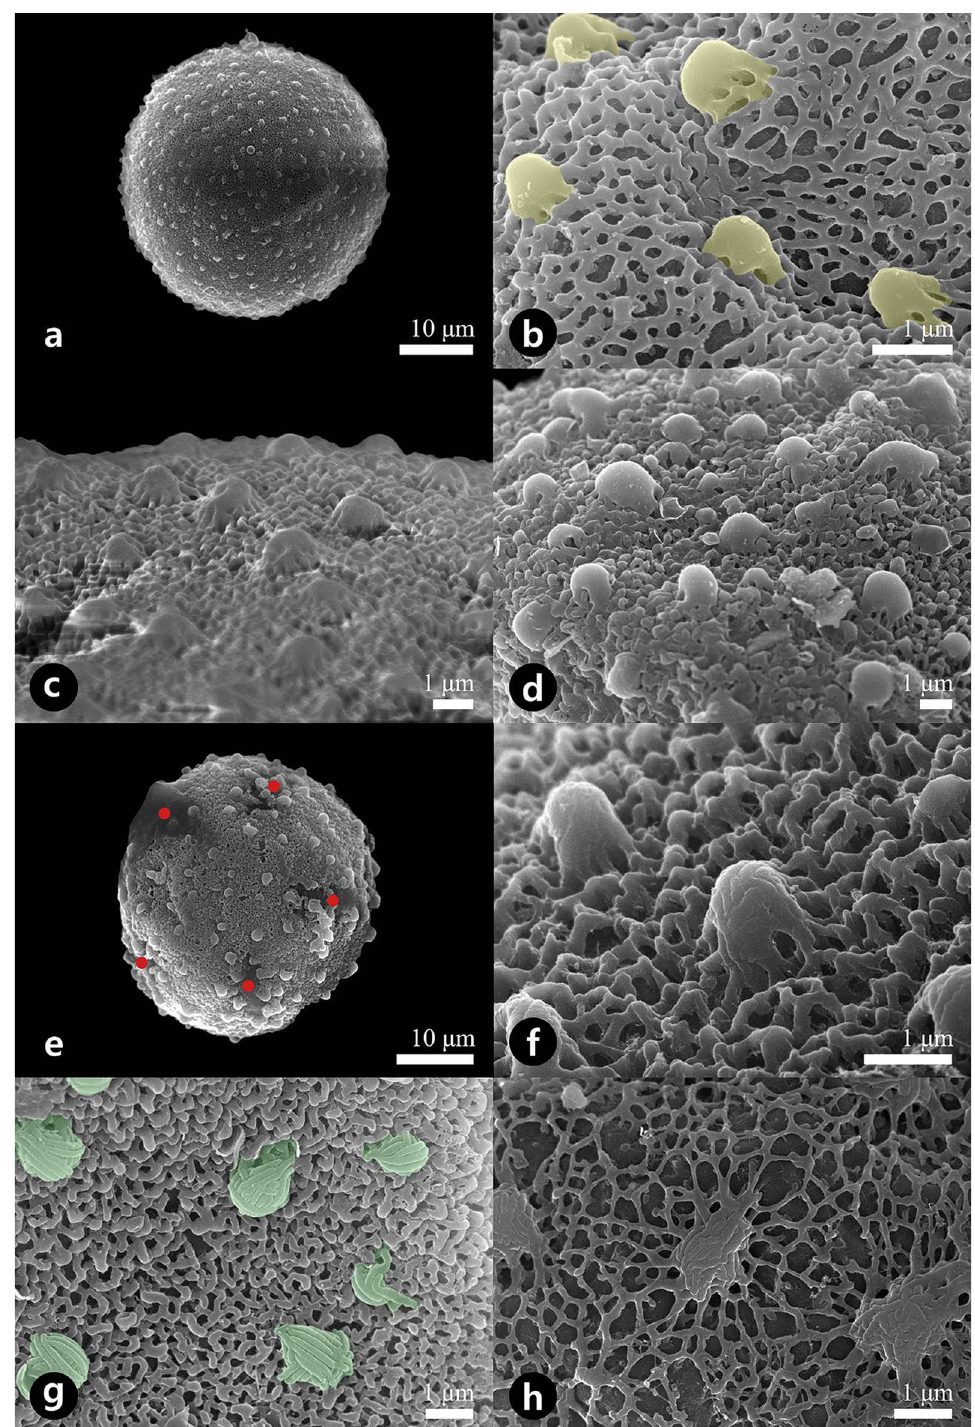
Figure 3. Scanning electron micrographs showing the pollen grains ( a , e ) and detailed surface ornamentation ( b – d , f – h ). ( a , b ) Asarum mandshuricum var. mandshuricum . ( c ) Asarum misandrum . ( d ) Asarum versicolor . ( e ) Asarum patens . ( f ) Asarum mandshuricum var. seoulense . ( g ) Asarum koreanum . ( h ) Asarum sieboldii . Yellow color indicates smooth-surfaced gemmae and these patterns are correlated with those of Fig. 5e. Green color indicates striate-surfaced gemmae and these patterns are correlated with those of Fig. 5d. Red dots indicate